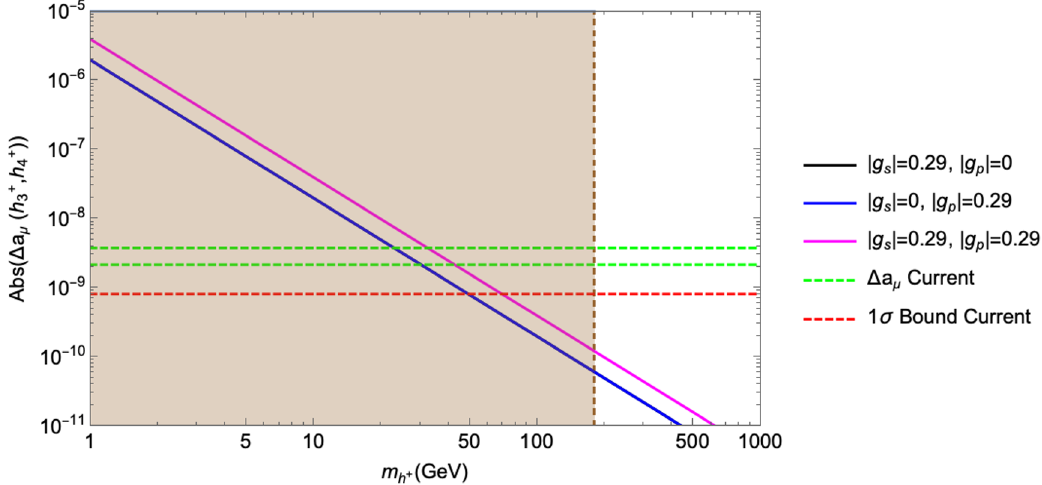
Figure 10 . Plot showing the contribution of neutral vector boson Z R to (cid:1) a (cid:22) for the case g L The black line, blue line and magenta line represent the contributions of Z R when purely vector-like, purely axial vector-like and the combination of both couplings are considered non-zero respectively. Even though all contributions are positive and sensitive to the current bounds on (cid:1) a (cid:22) , none of the cases satisfy the bound on Z R mass since all the mass values which can satisfy the muon anomaly bounds are residing in the brown shaded excluded mass range.